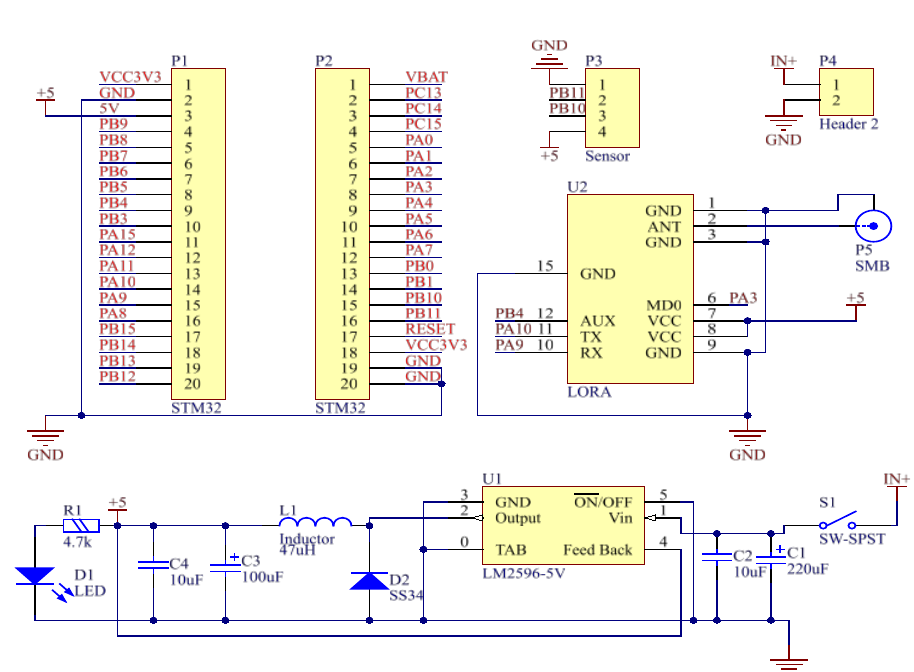
Fig. 1. Schematic diagram of the